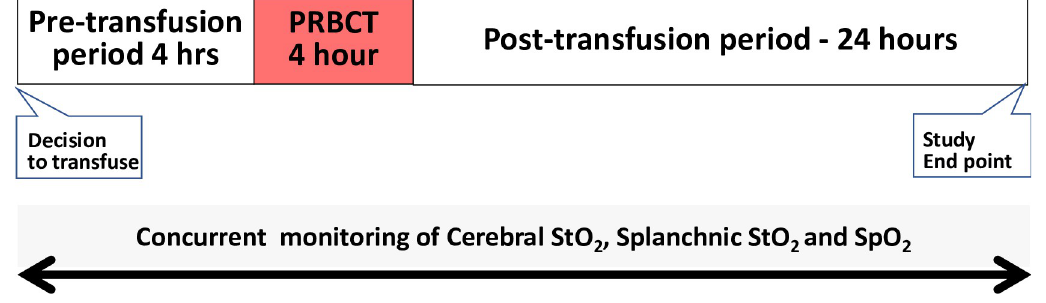
Fig 1. Outline of the study procedure. PRBCT, Packed red blood cell transfusion; SpO 2 , arterial oxygen saturation measured by Pulse Oximetry; StO 2 , tissue oxygen saturation measured by near-infrared spectroscopy; FTOE, Fractional tissue oxygen extraction derived from StO 2 and SpO 2 .